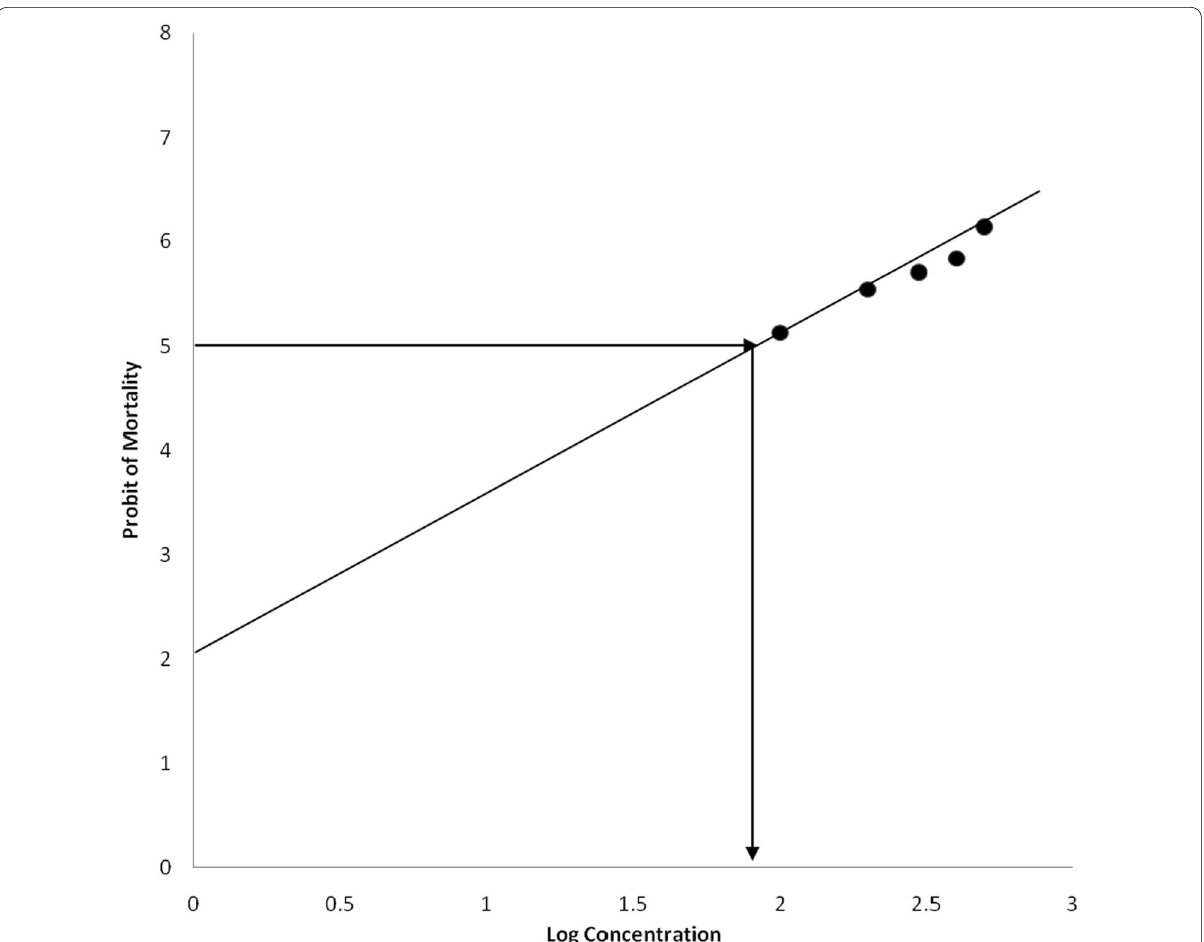
Fig. 3 Graph of Probit of Mortality of Anopheles larvae /Log of Concentration of Ethanolic Leaf Extract of Allium sativum showing the LC 50 at Lethal